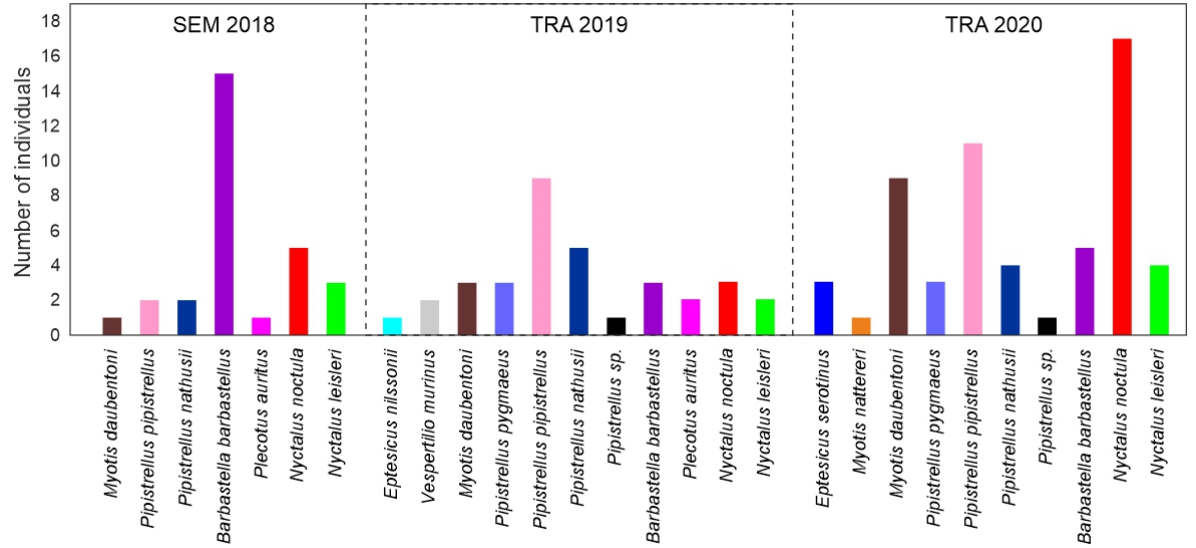
Figure 8. Catch results in 2018 (before transformation) (SEM), and in 2019 and 2020 (TRA) after transformation to waterholes for European bison.